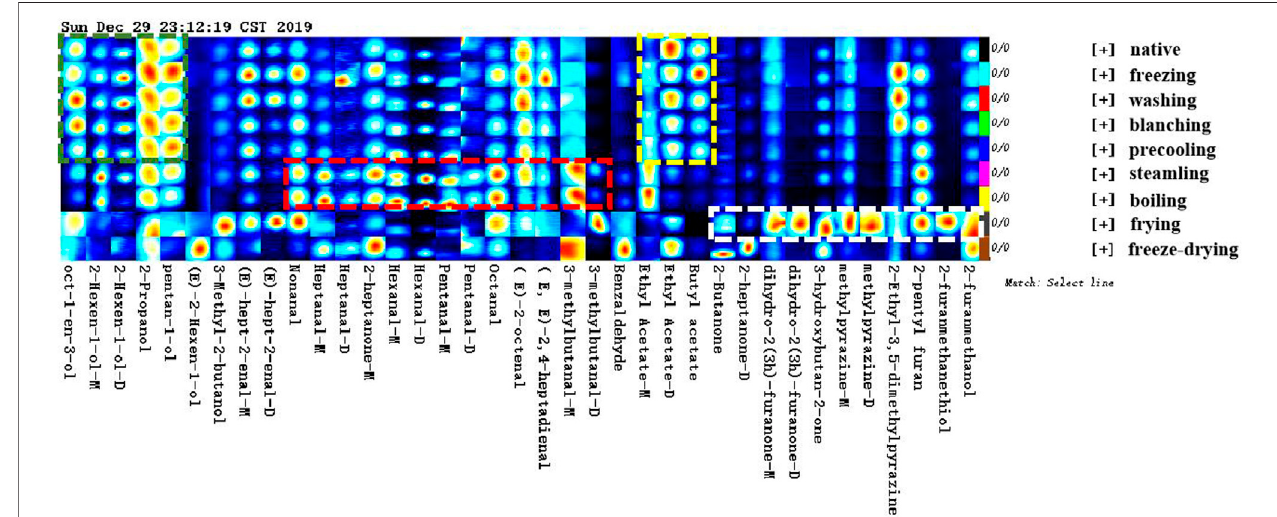
FIGURE 2 | Gallery plot fi ngerprint of corn under nine kinds of different